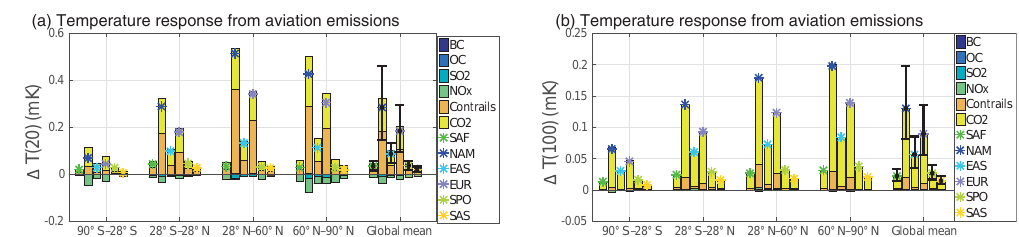
Figure 3. Regional and global-mean temperature change by species and source region after (a) 20 years and (b) 100 years following a 1-year pulse of emission from the present-day aviation sector in each source region. The asterisk shows the net temperature response in the respective latitude band for each emission source region, while the bars show the contribution from each species to the net. Error bars show the 1SD ranges due to uncertainties in RF and